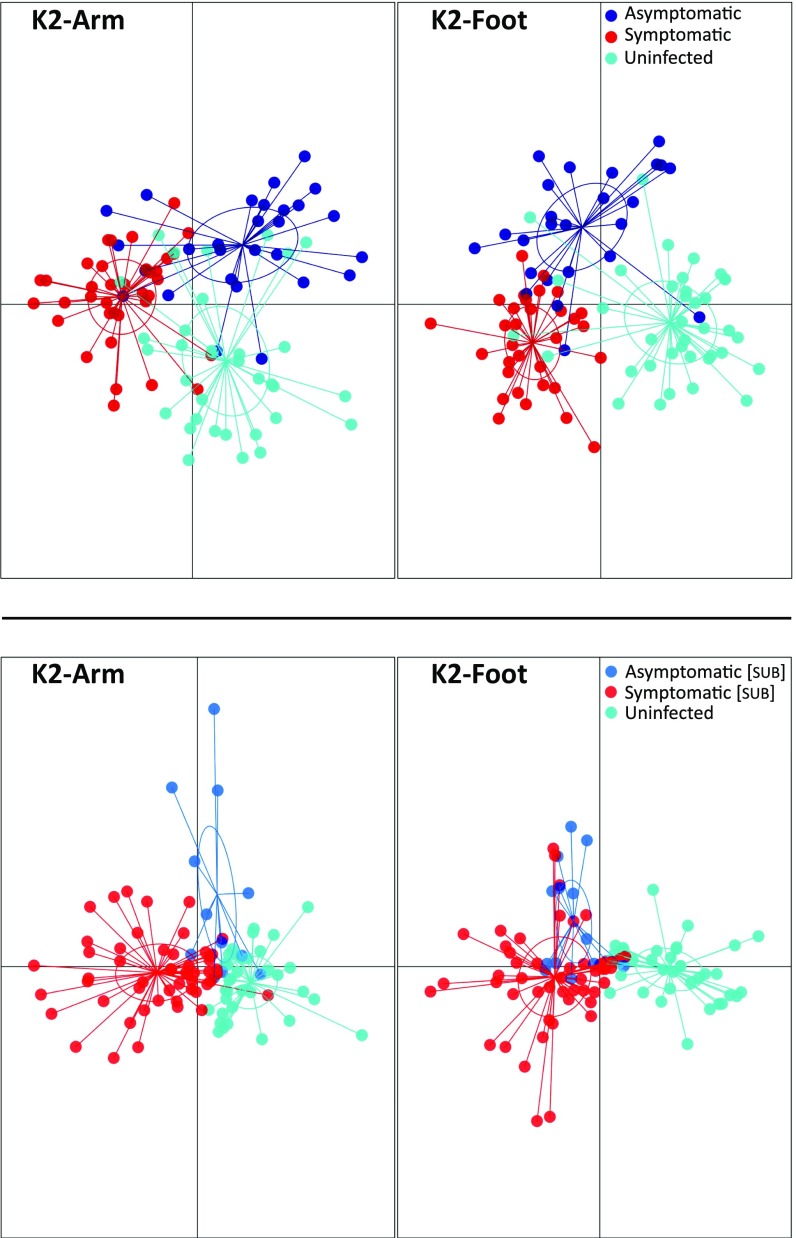
Group separation using DAPC for K2 arm and foot volatiles. (Top) Differences among uninfected individuals and individuals with symptomatic and asymptomatic malaria infections, confirmed by both microscopy and PCR. (Bottom) Differences among uninfected individuals and individuals with submicroscopic symptomatic and asymptomatic infections, detected only by PCR. Points represent individual samples, with colors denoting malaria condition and inclusion of 95% inertia ellipses.